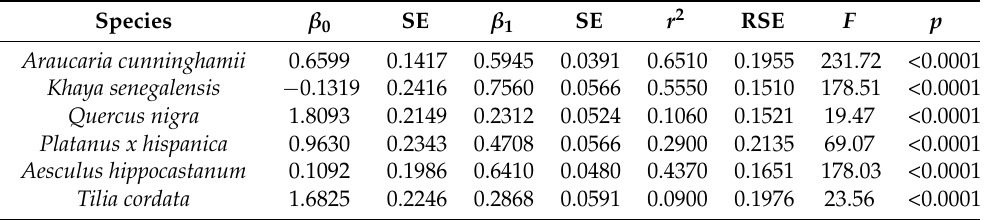
Table 4. Linear regression models for stem diameter ( d ) to tree height ( h ) Equation (12) for all six species (ordered according to